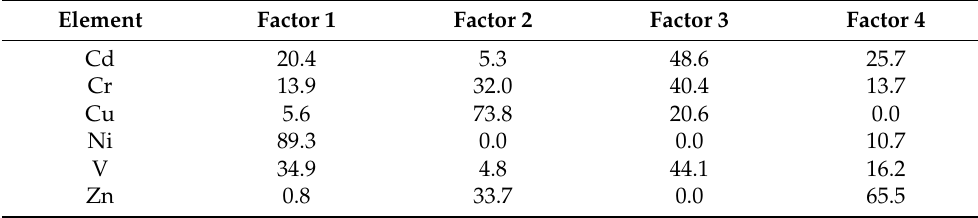
Table 7. Threshold values in mg × kg − 1 . Table 5. Percentage of contribution of the source to the total of each heavy